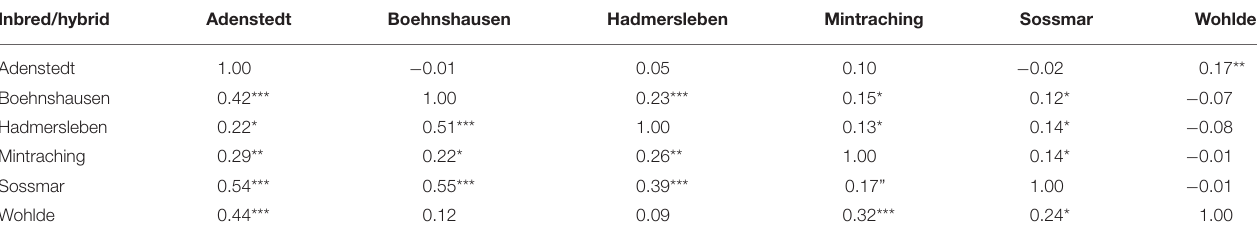
TABLE 2 | Estimates of variance components (residual variance indicated as σ e ) and heritability ( h 2) for winter wheat for grain yield (dt/ha). Source